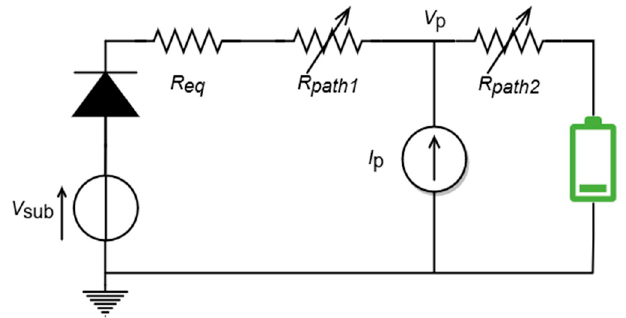
Figure 10. Schematic of the train running between the substation and the ESS.